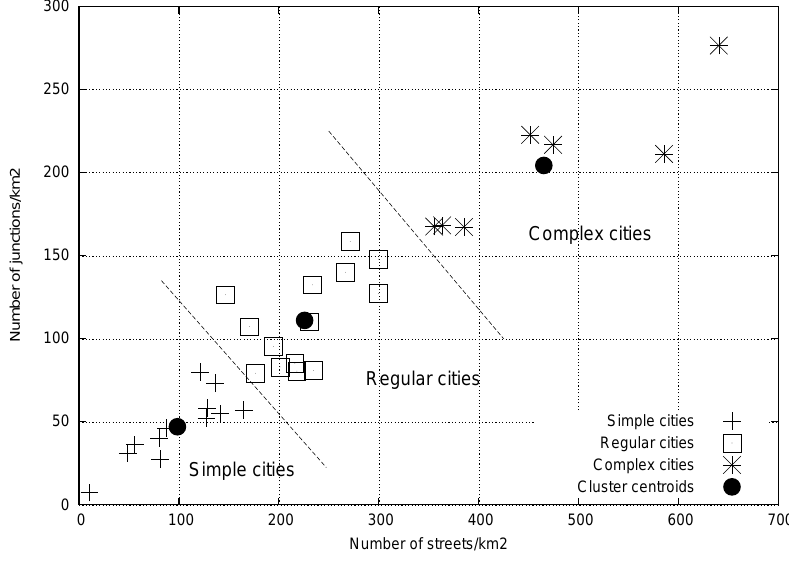
Figure 9. Classification of different cities based on the density of streets and junctions.